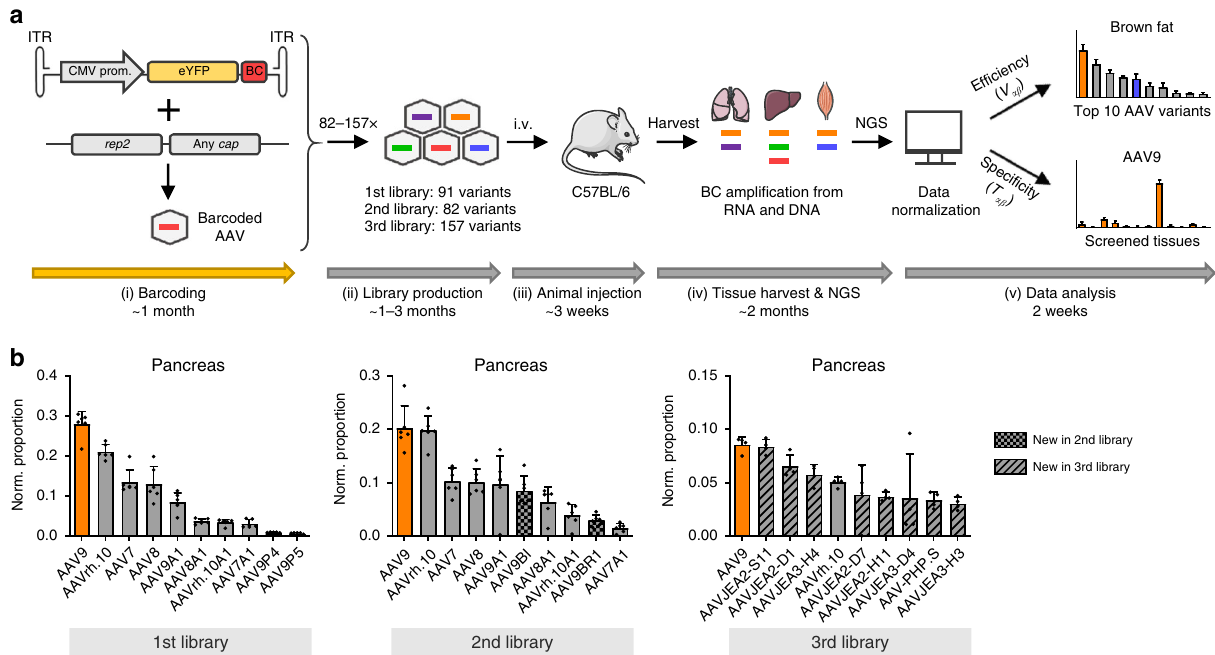
Fig. 1 A robust work fl ow for massively parallel in vivo AAV capsid strati fi cation. a Experimental setup. Shown are the essential experimental and bioinformatic steps, from the (i) cloning of barcoded YFP reporter vectors, (ii) library production, and (iii) animal (mouse here) injection, to (iv) tissue harvest and NGS, followed by (v) data analysis. Also shown is a timeline for the entire work fl ow or the individual steps. Note that the exact time required in step (ii) depends on the size of the library. Likewise, the time to perform the fi nal bioinformatic analysis in step (v) is determined by available computing (IT) power. The fi rst step (orange arrow) can be skipped if users start with our pre-existing collection of barcoded vector genomes, which will cut down the required overall time to <6 months. Please see the main text for further details. b Ranking of capsids in all three libraries by transcriptional ef fi ciency ( V αβ ) in the pancreas. Shown are the top ten AAV variants and the proportion of their transcriptional ef fi ciency after normalization to all capsids or barcodes, respectively, in each library. Depicted values are the average from six C57BL/6 J mice with SD. BC, barcode; i.v., intravenous. This fi gure contains clipart from Servier Medical Art. Source data are available in the Source data fi